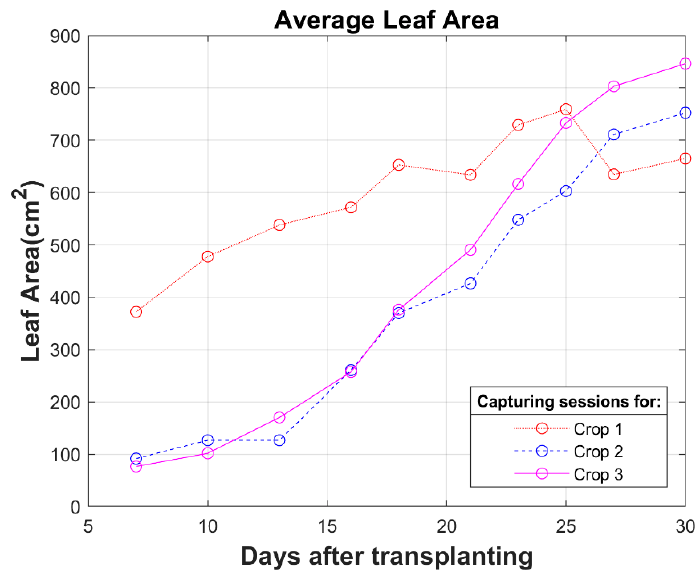
Figure 11. Average leaf area for three crops.